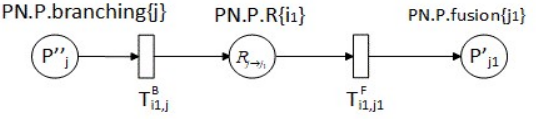
Figure 4. Petri net model for j → j 1 direction of two-way road segment i 1 .